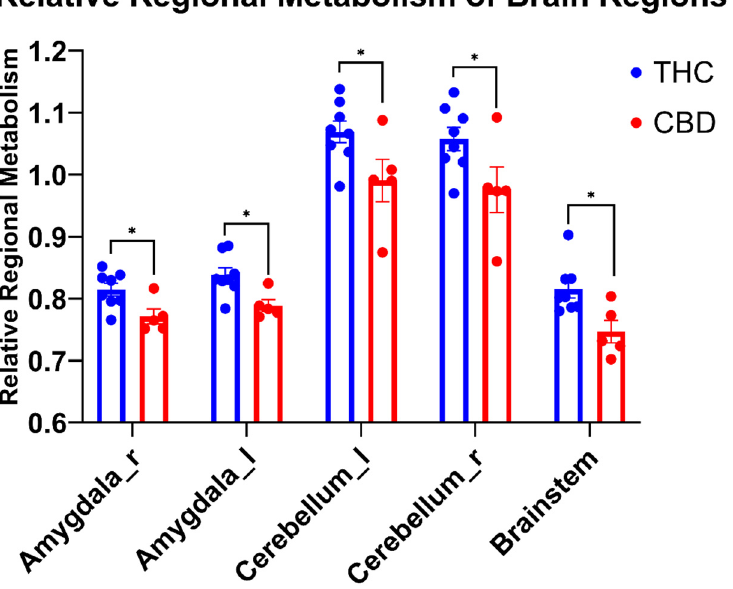
Figure 2. Comparisons of THC and CBD users in relevant brain regions. Data are mean ± SEM. * THC users had significantly higher relative regional metabolism ( p ≤ 0.05) for all brain regions shown. Amygdala_r, right amygdala; Amygdala_l, left amygdala; Cerebellum_l, left cerebellar lobule; Cerebellum_r, right cerebellar lobule.